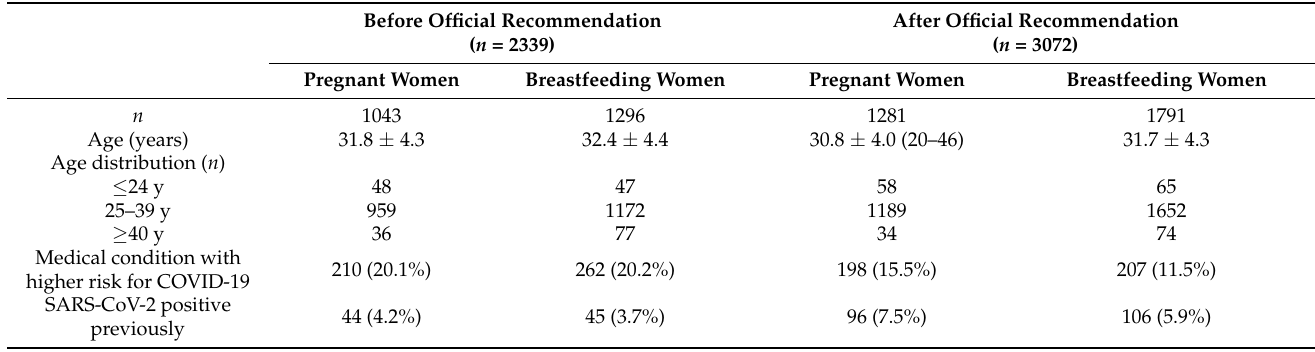
Table 1. Characteristics of pregnant and breastfeeding